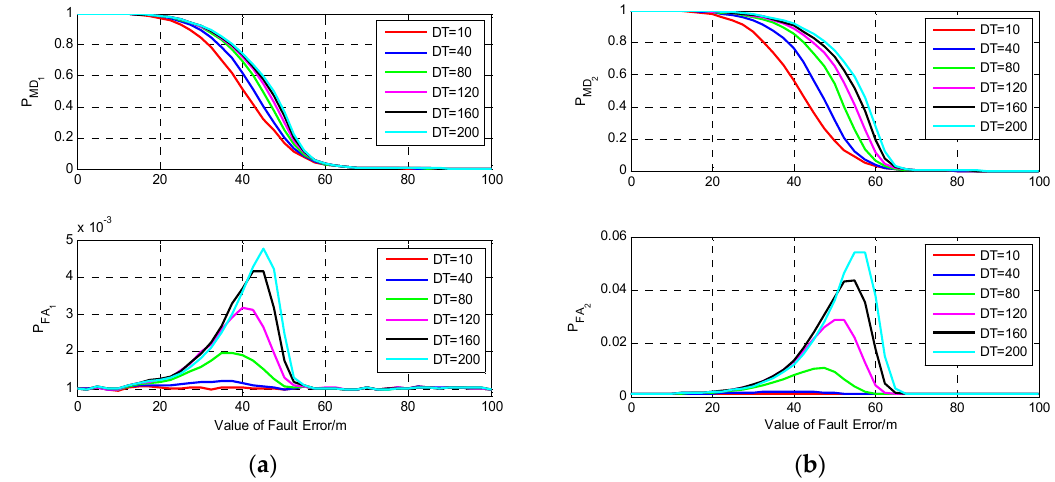
Figure 10. The results of fault detection with four visible satellites. ( a ) Fault occurs on S1; ( b ) Fault occurs on S2.